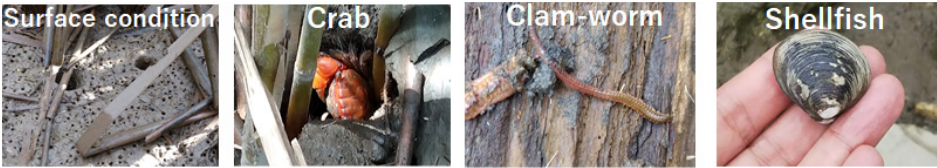
Figure 4. Brackish water organisms that form burrows in the ground.